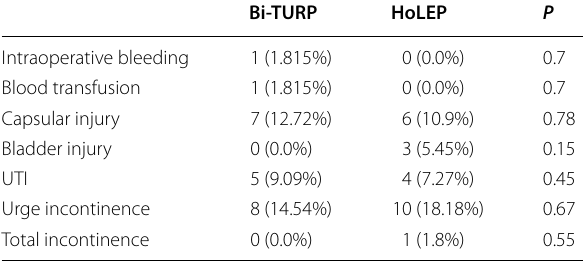
Table 4 Intra- and postoperative